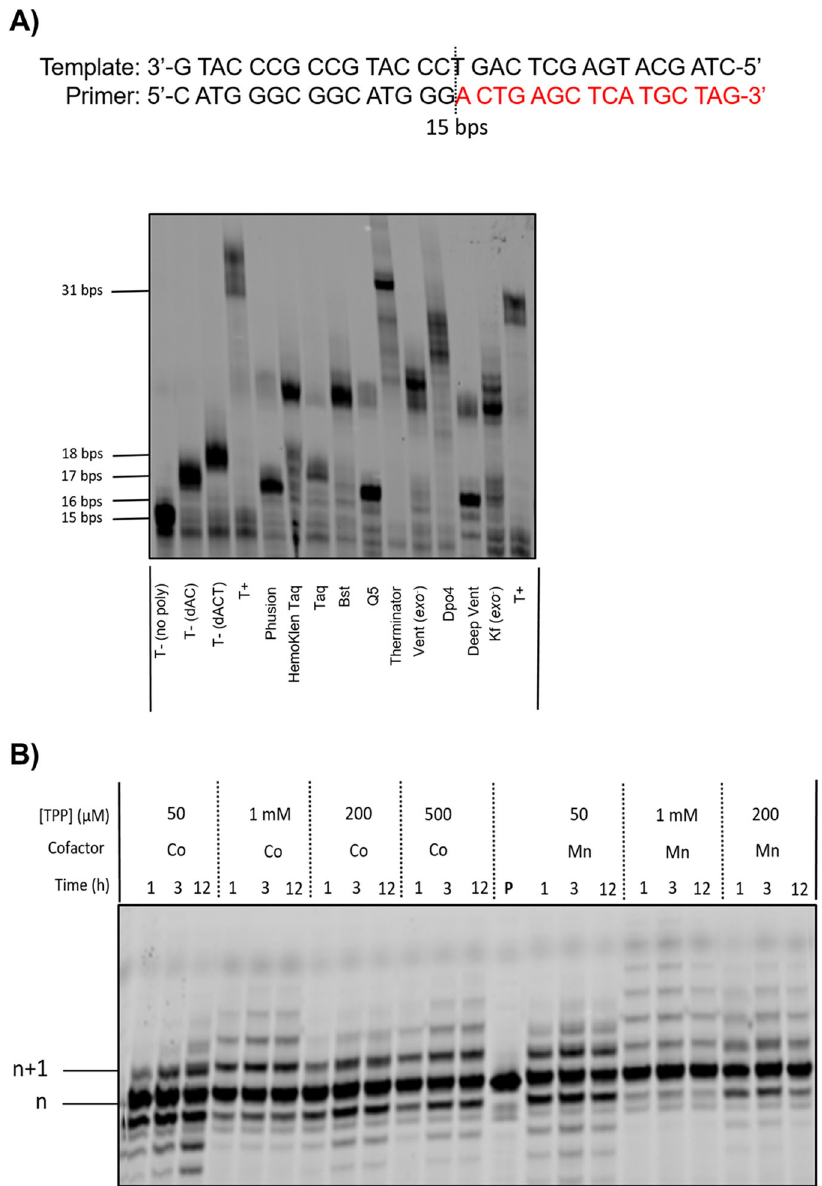
Fig. 9 Biochemical evaluation of nucleotide 15. Gel image (PAGE 20%) shows the analysis of the products stemming from ( A ) PEX reactions with various DNA polymerases and the P1 / T1 system and ( B ) TdT-mediated extension reactions with 5 ′ -FAM-labeled primer P2 . PEX reaction contained natural and modi fi ed triphosphates at 200 µ M. The following quantities of polymerases were used: Phusion (2 U), Hemo Klen Taq (8 reactions), Taq (5 U), Bst (8 U), Q5 (2 U), Therminator (2 U), Vent (exo − ) (2 U): 60 °C, 30 min; Dpo4 (2 U), Deep Vent (2 U): 55 °C, 30 min; Kf (exo − ) (5 U): 37 °C, 30 min. Negative control (T − ): No polymerase added to the mixtures or reactions with only dATP and dCTP or dATP, dCTP, and dTTP only. Positive control (T + ): with all natural nucleotides and Taq polymerase. All reactions were incubated at adequate reaction temperatures for 1 h. TdT reaction mixtures contained TdT (10 U), triphosphate at various, given concentrations, Co 2 + (0.25 mM) or Mn 2 + (1 mM) cofactors, and were incubated at 37 °C for given reaction times. P represents unreacted, 5 ′ -FAM-labeled